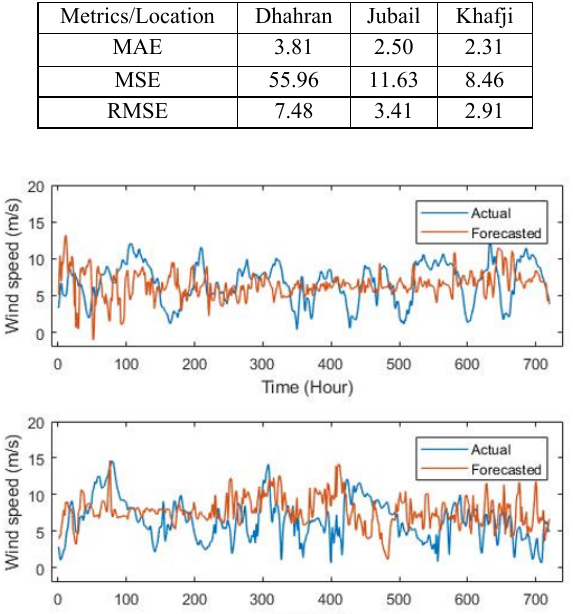
Figure 11. Forecasted and measured wind speeds for 2017, Jan & Feb. Dhahran, Case I.